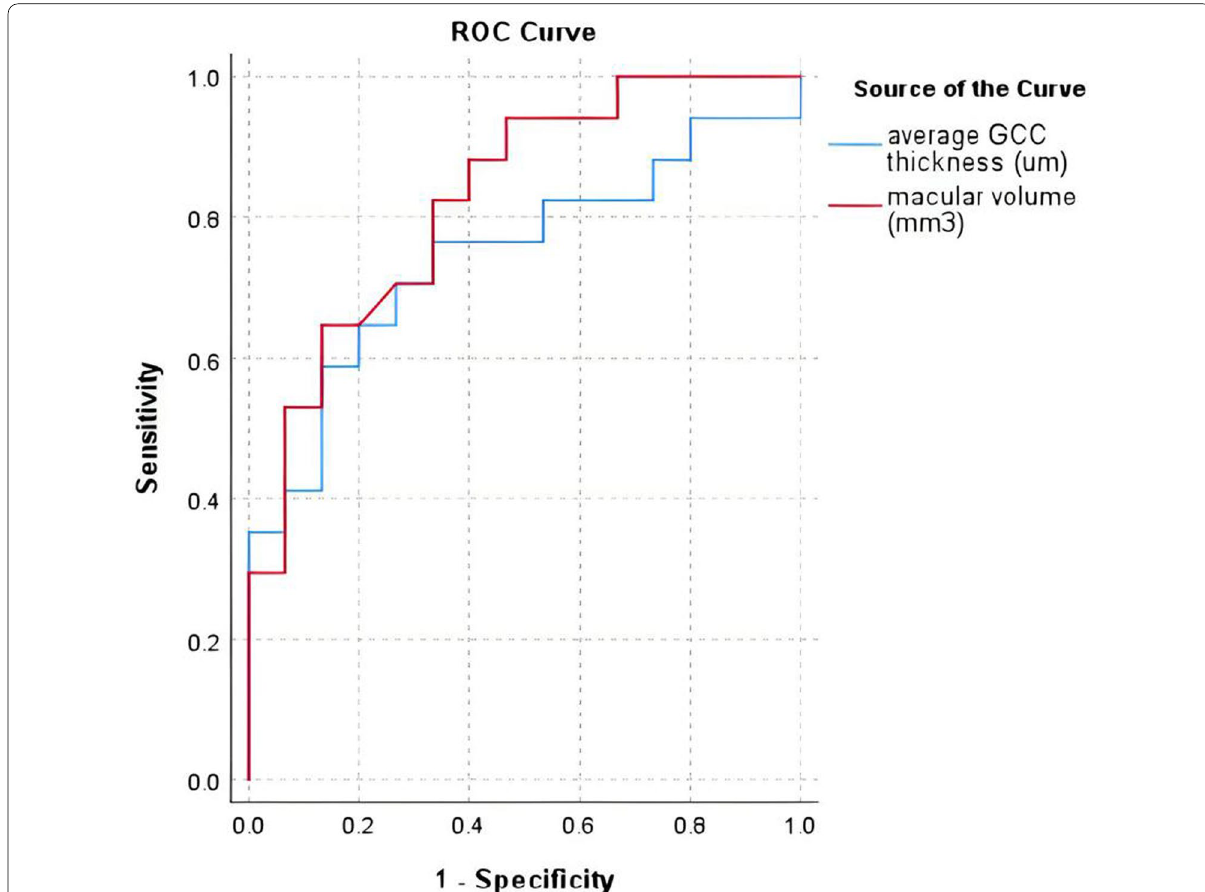
Fig. 2 ROC curves for of average GCC thickness and macular volume as biomarkers to detect disease severity in patients with PD. GCC ganglion cell complex; PD Parkinson’s